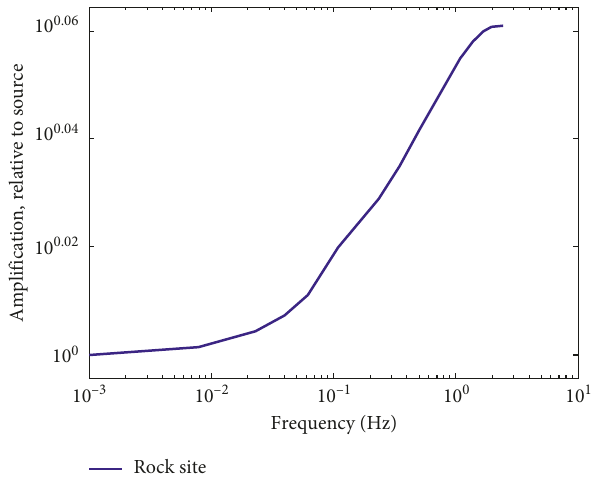
Figure 3: Amplification vs. frequency.